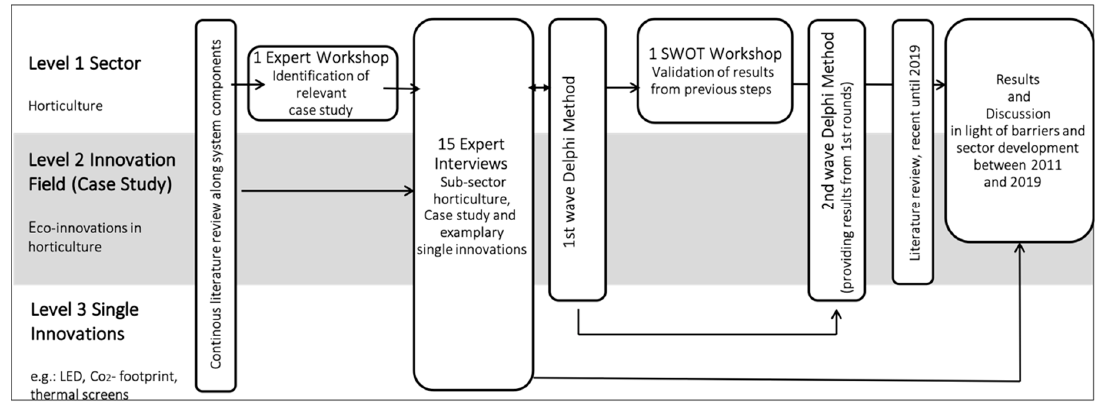
Figure 1. Research design (own figure based on [33]).